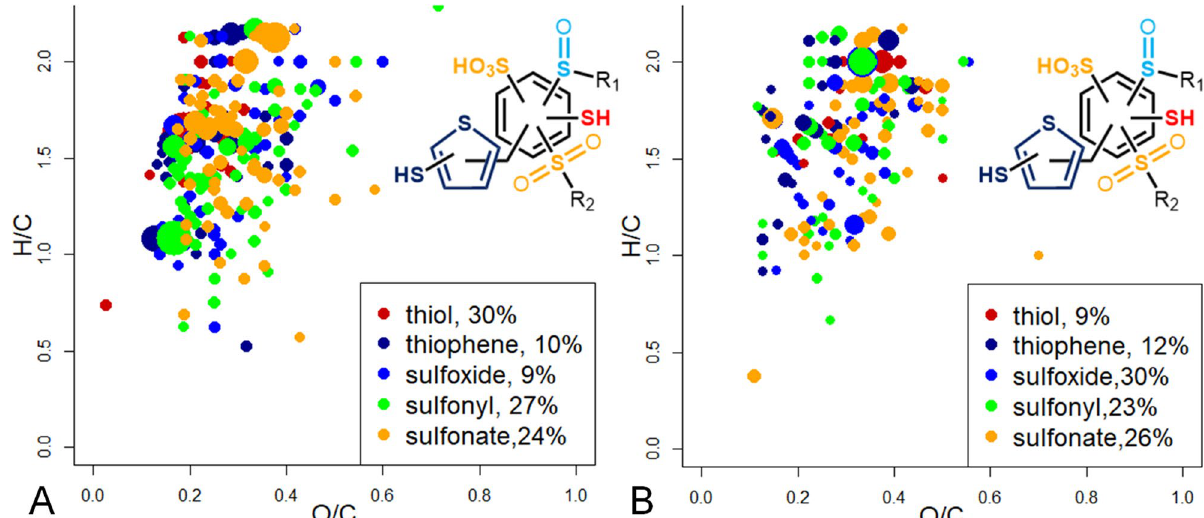
Figure 10. Van Krevelen diagrams with the assigned types of sulfur atoms identified by HDX in alkaline extracts from ( A ) Murchison, ( B ) Allende IOM—thiol, thiol or thiophene, sulfoxide, sulfonyl and sulfonic groups are highlighted in red, dark-blue, blue, green and orange colors, respectfully. The insets show the relative abundance of different sulfur types in CHOS